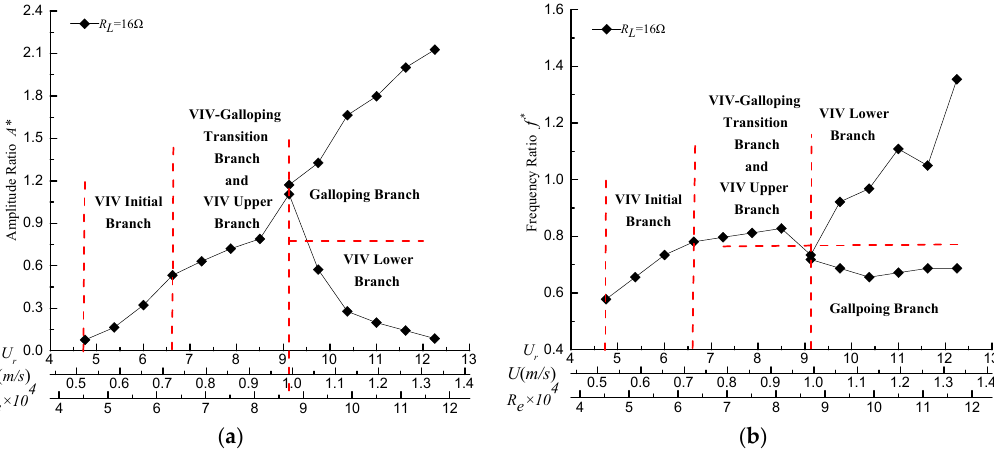
Figure 10. Critical galloping (CG) oscillation characteristics R L = 16 Ω ( ζ = 0.177): ( a ) response of the amplitude ratio; ( b ) response of the frequency ratio.